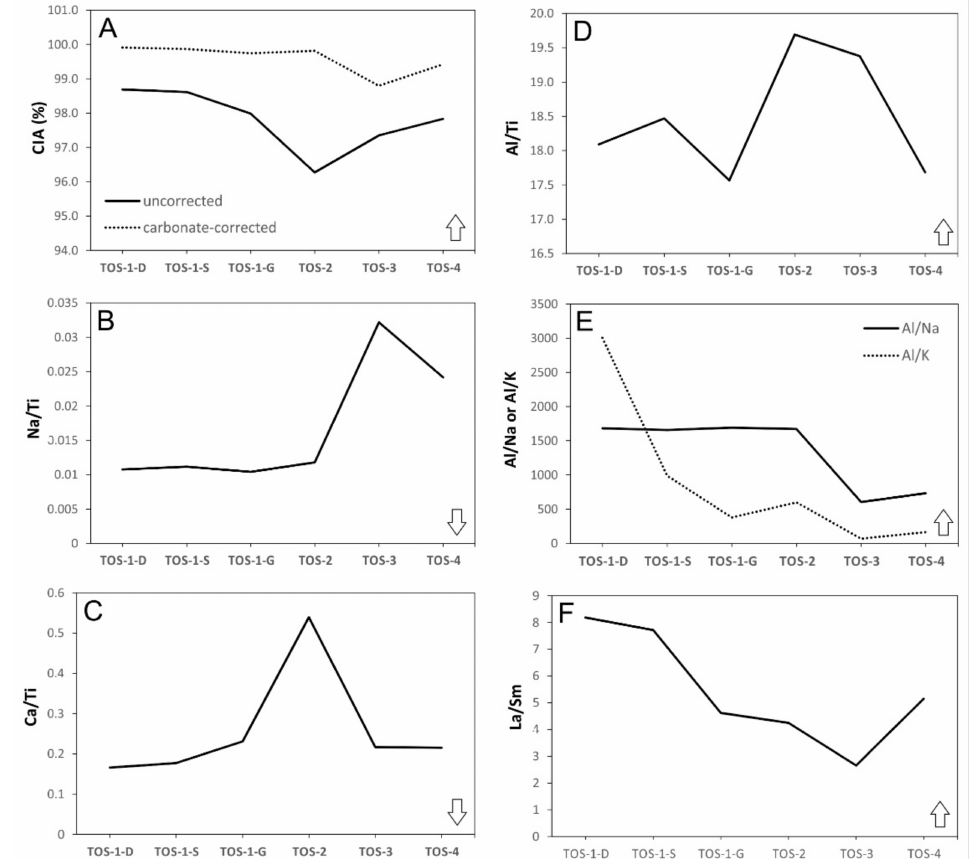
Figure 11. Binary plots of weathering proxies showing intensity of chemical weathering for the bauxite samples from Toši´ci-Duji´ci deposit (arrow in bottom right corner of each diagram indicates if smaller ( ↓ ) or higher ( ↑ ) values imply greater chemical weathering): ( A )—chemical index of alteration (CIA); ( B )—Na/Ti; ( C )—Ca/Ti; ( D )—Al/Ti; ( E )—Al/Na and Al/K; ( F